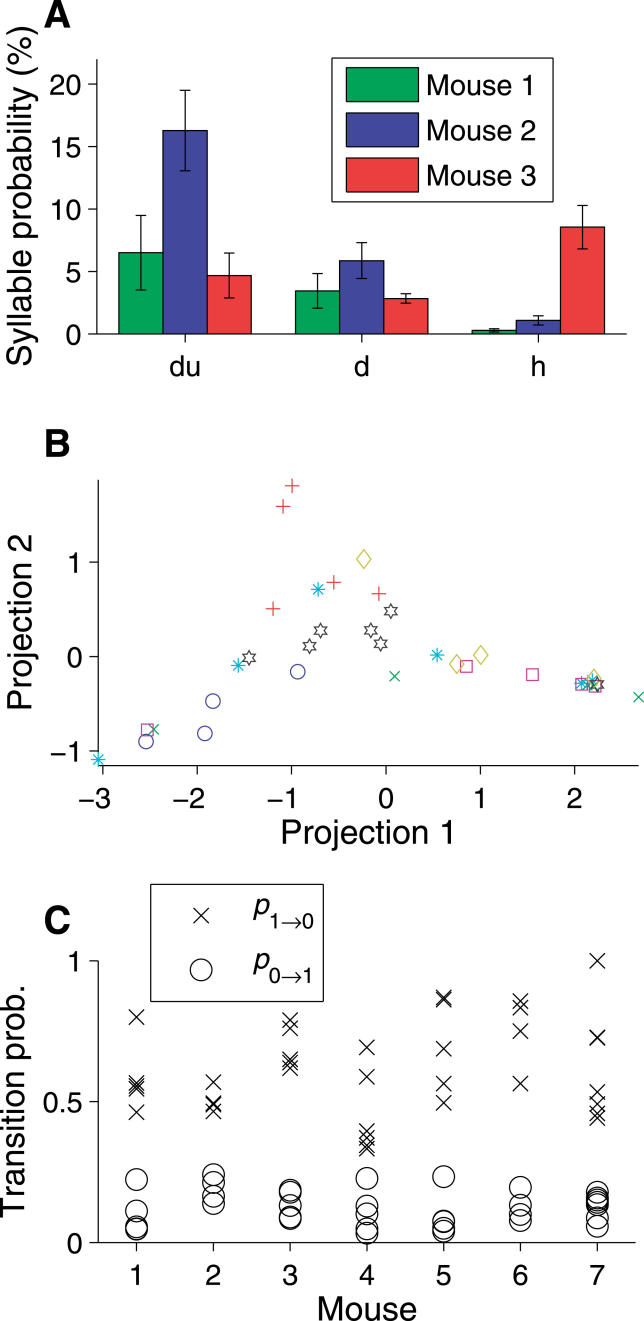
Regularities in the Songs of Individual MiceAll seven mice with four or more qualifying trials (see text) are analyzed.(A) Syllable usage for three of the more common syllable types for three different mice. Error bars represent the standard error of the mean across trials.(B) Patterns of syllable usage on individual trials across mice. Each point corresponds to a single trial, where the trials from a particular mouse are marked with a consistent color and marker. For mice 1–3, colors are consistent between (A) and (B). Placement of points in the plane reflects the pairwise “distance” between trials, where that distance measures the overall differences in percentage of each syllable type (see Materials and Methods). Projection into two dimensions was performed by isomap.(C) Temporal regularities in song structure. Transition probabilities for all qualifying trials grouped by mouse.